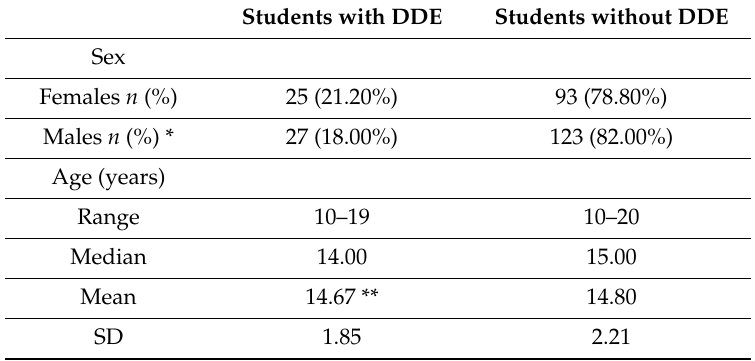
Table 3. Percentage of females and males a ff ected by DDE, and age of students with DDE and without